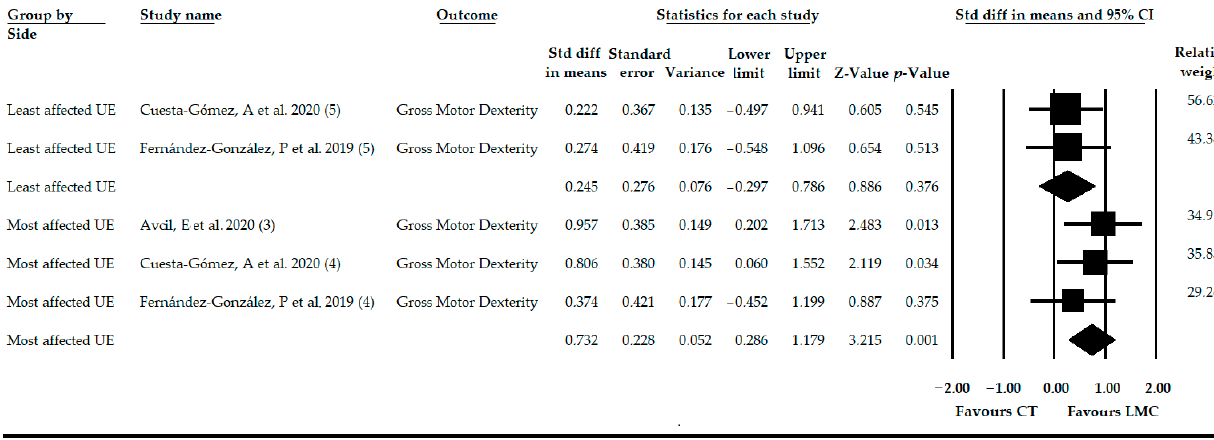
Figure 4. Forest Plot of the effect of LMC-based therapy on recovery of gross motor dexterity in patients with non-acute CNSD.